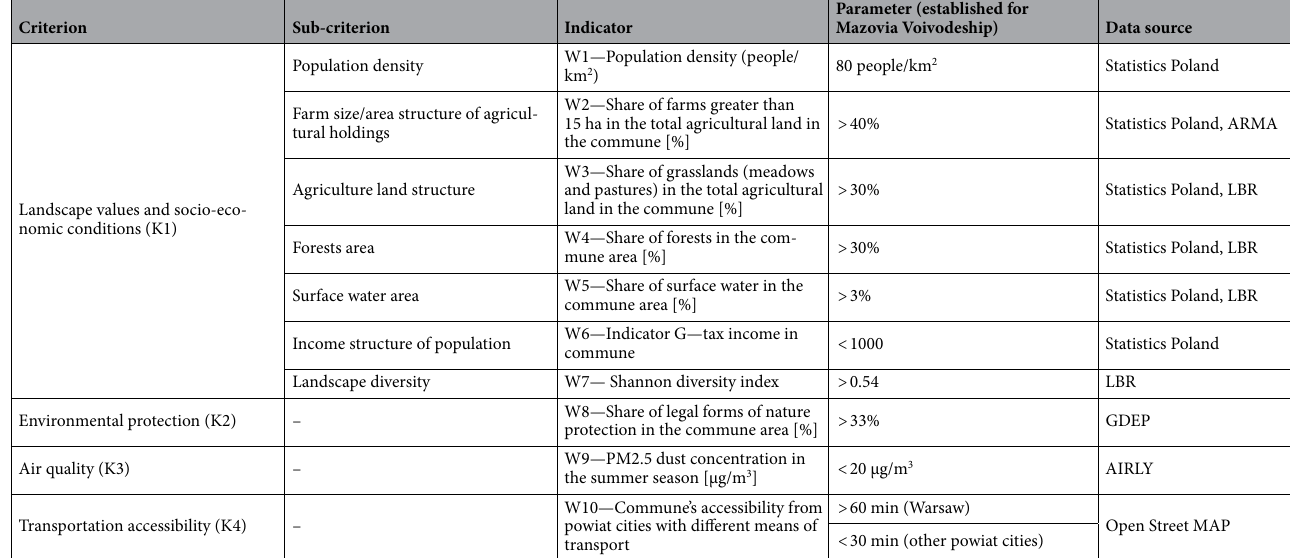
Table 1. Criteria for assessing tourist and recreational potential (Source: Own